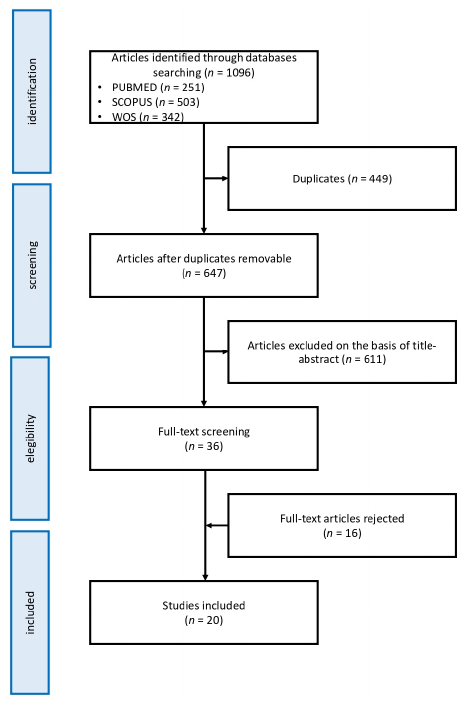
Figure 1. Study selection flow chart.